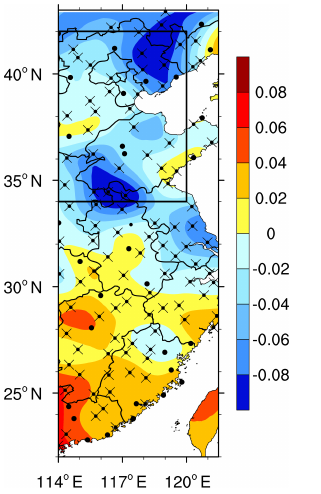
Figure 1. The spatial pattern (shading) of the first EOF mode (vari- ation contribution: 33%) for HDJ from 1979 to 2015. The black crosses and dots represent the locations of the observation stations. The cross (dot) indicates that the HDJ accounted for more (less) than 70% of the total winter haze days.